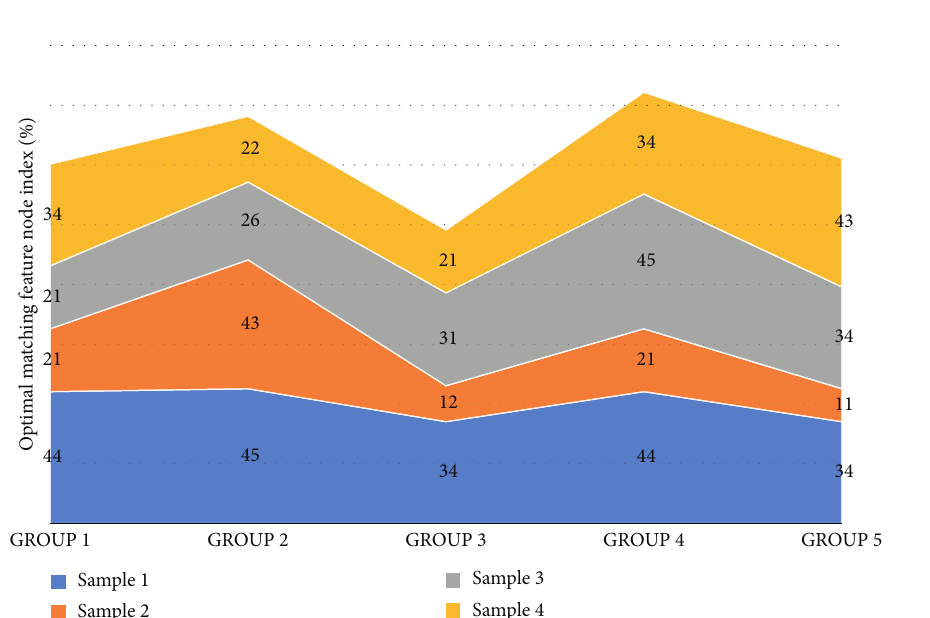
Figure 2: Layout of Internet finance